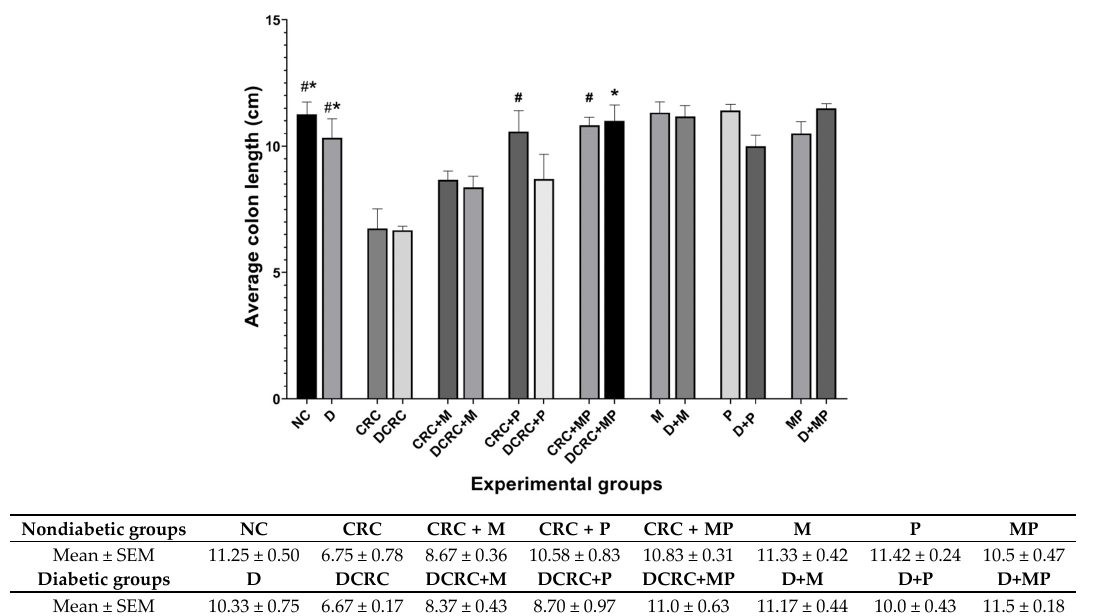
Figure 5. Colon length variation. Average colon length (cm) was recorded on the day of sacrifice at week 13 Nondiabetic groups were compared to their experimental CRC control (CRC), significance was expressed by # p < 0.05. On the other hand, diabetic groups were compared to their experimental diabetic CRC control (DCRC), and significance was defined as * p < 0.05, with n = 6 animals per group.